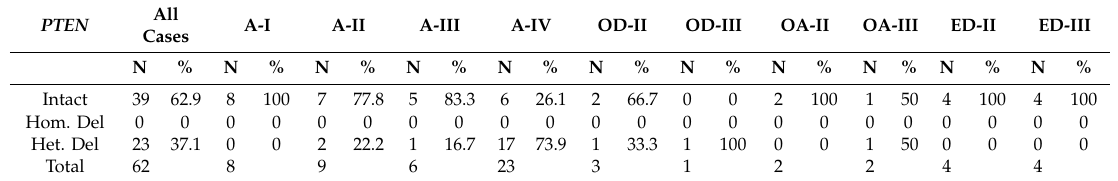
Figure 5. Patients’ mean age according to PTEN gene status. Table 4. Frequency of PTEN deletion in each histologic and WHO grading group.